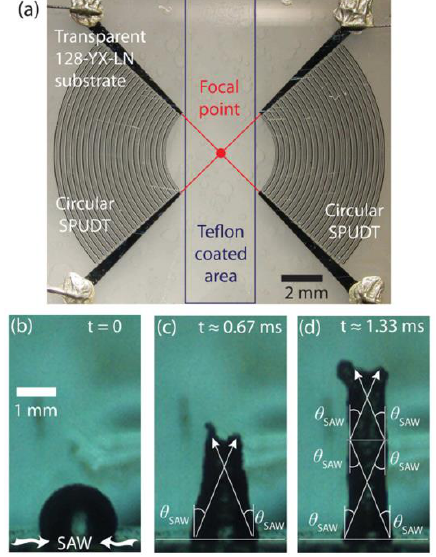
Figure 17. Focused electrode configuration and F-SAW on liquid manipulation [77]. ( a ) a droplet is placed into the directed area on which the focused SAWs radiate into the droplet. Jet formation of the droplet at time ( b ) t = 0 s, ( c ) t = 0.67 ms and ( d ) t = 1.33 ms due to focused SAW exposure.